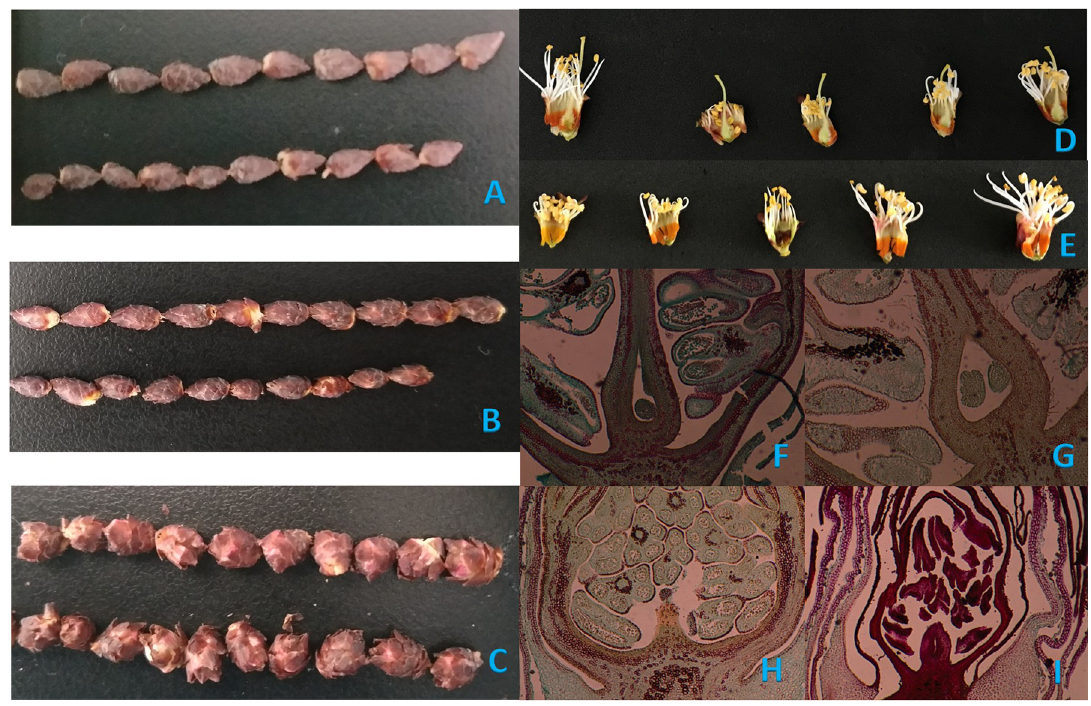
Fig 1. Morphology of flower buds of ‘Shajinhong’ apricots. (A) The features of flower bud of spur twigs (up) and long branches (down) at stage I. (B) The features at stage II. (C) The features at stage III. (D) The features of normal flowers. (E) The features of aborted flowers. (F) and (G), the vertical section of normal flower bud. (H) and (I), the vertical section of aborted flower